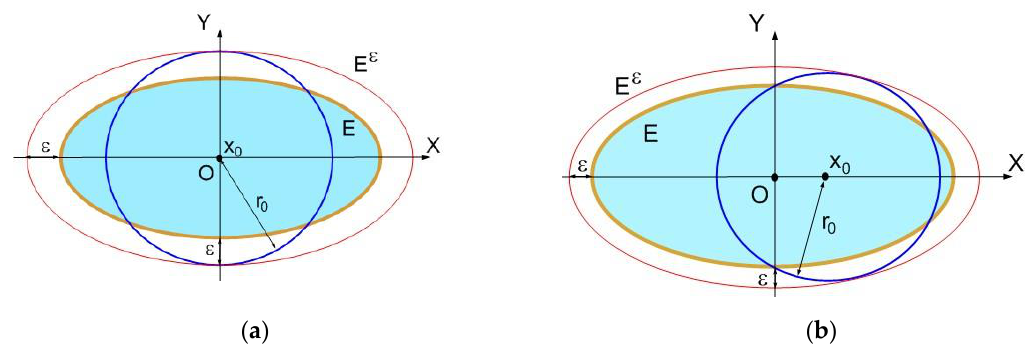
Figure 1. The center of the first approximating circle: ( a ) for odd circular covering and ( b ) for even circular covering.